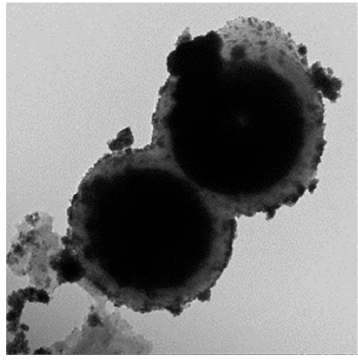
Figure 3. TEM images of Fe 3 O 4 @NC/Pd catalyst.